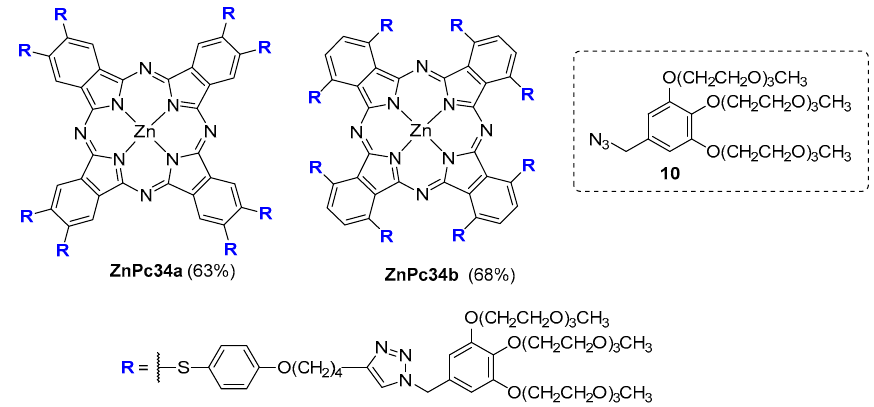
Figure 3. Structures of the dendritic zinc(II) Pcs ZnPc34a and ZnPc34b , and of the azide 10 used in their preparation.